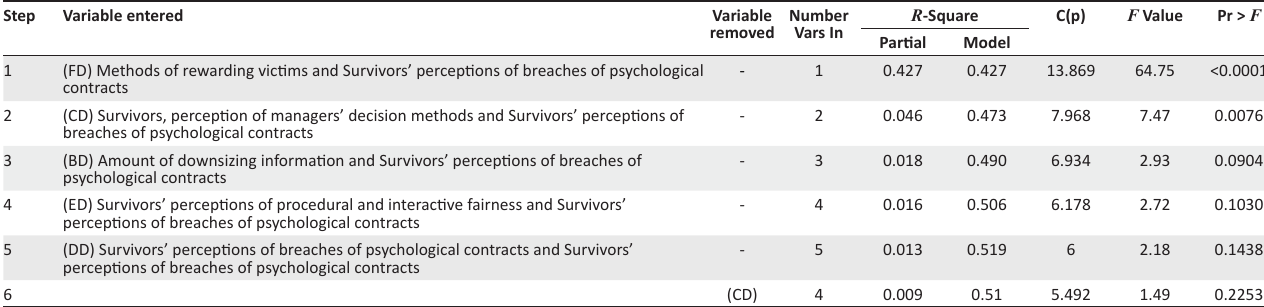
TABLE 8: Regression of organisational citizenship behaviour (summary of stepped-selection procedure).